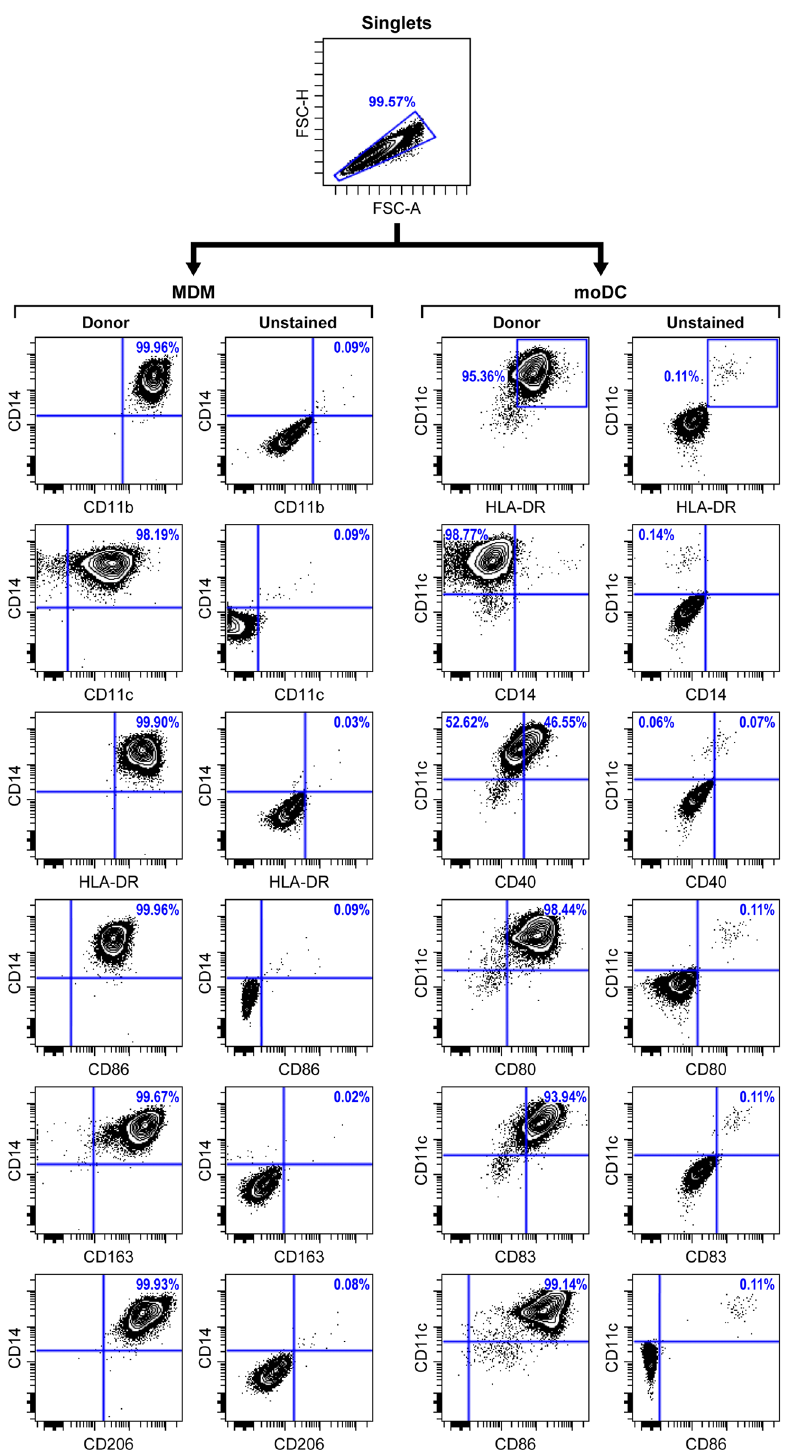
Fig 1. Gating strategy for phenotyping of MDM and MoDC. Following differentiation and maturation, MoDC and MDM were characterized by flow cytometry. The gating strategy included initial gating on monocyte populations from the FSC-A vs SSC-A plot, followed by exclusion of doublets and then gating on viable cells. Within the viable cell population, CD14 was plotted against all other markers for MDM gating and CD11c was plotted against all other markers for MoDC gating. An unstained control was used to set the gating for all plots. Shown here is an example of typical populations determined in the phenotyping analysis.